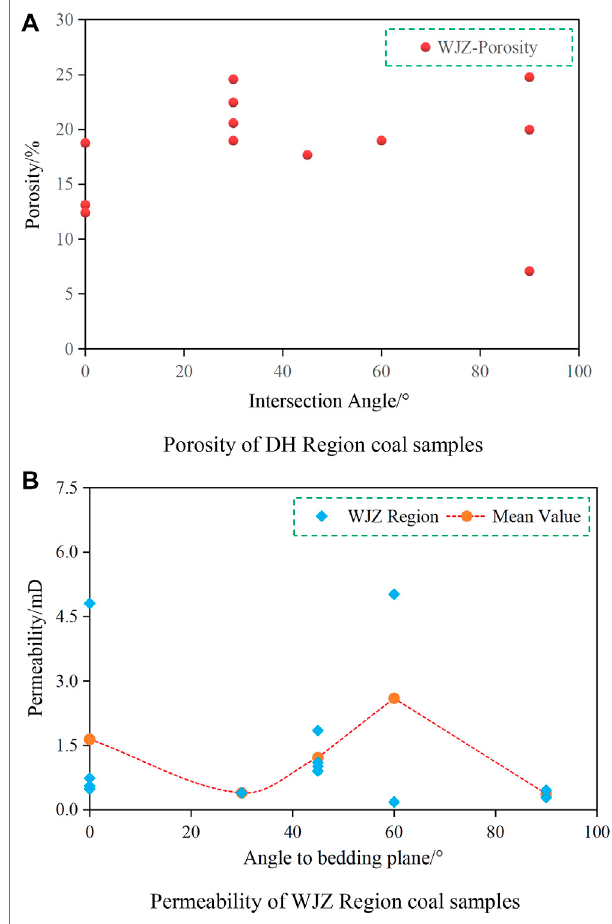
FIGURE 5 | Relationship between permeability and intersection angle of coal. (A) Porosity of DH Region coal samples (B) Permeability of WJZ Region coal